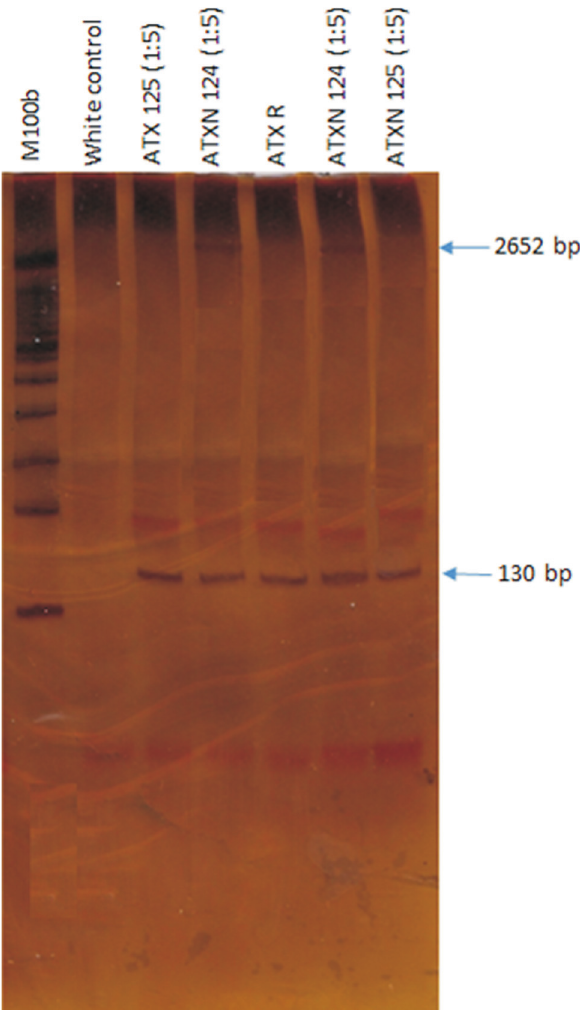
Figure 2 - PAGE gel showing in the 4 th and 6 th lanes the extreme CAG re- peats expansion